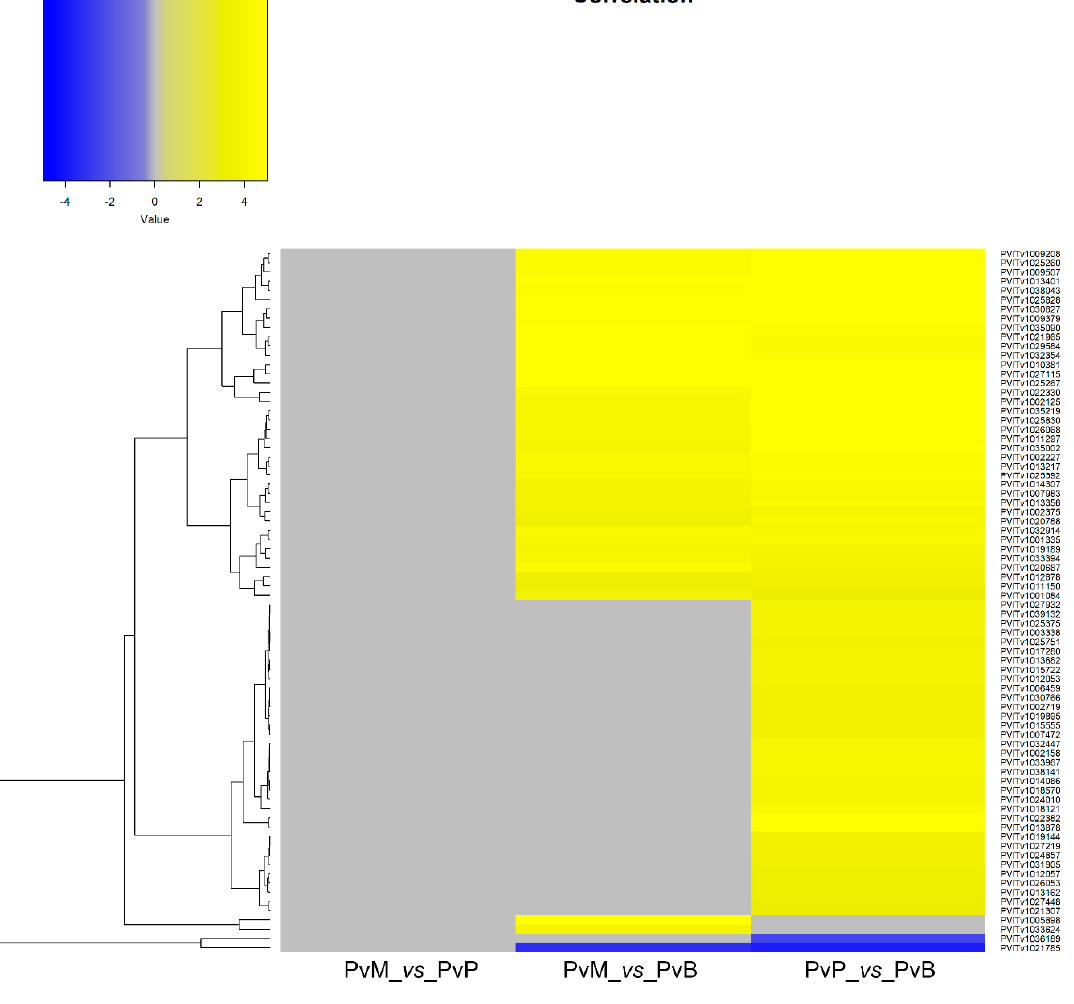
Figure 3. Heatmap of 76 genes encoding effectors possessing a signal peptide for secretion differentially expressed by Plasmopara viticola (Pv) following inoculation on Mgaloblishvili (M) and Pinot noir (P) (PvM_ vs _PvP), M and Bianca (B) (PvM_ vs _PvB), and P and B (PvP_ vs _PvB). Fifty-seven transcripts, corresponding to four cytoplasmic effectors (three RXLR: PVITv1011807, PVITv1009474, PVITv1003492; and one YXSLK: PVITv1002853), fifteen apoplastic effectors (from